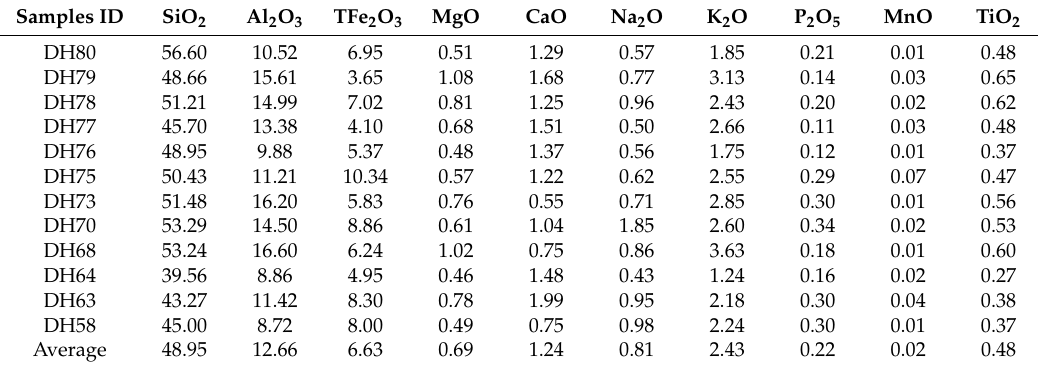
Table 1. Major elements concentration in oil shale samples (unit in wt %).